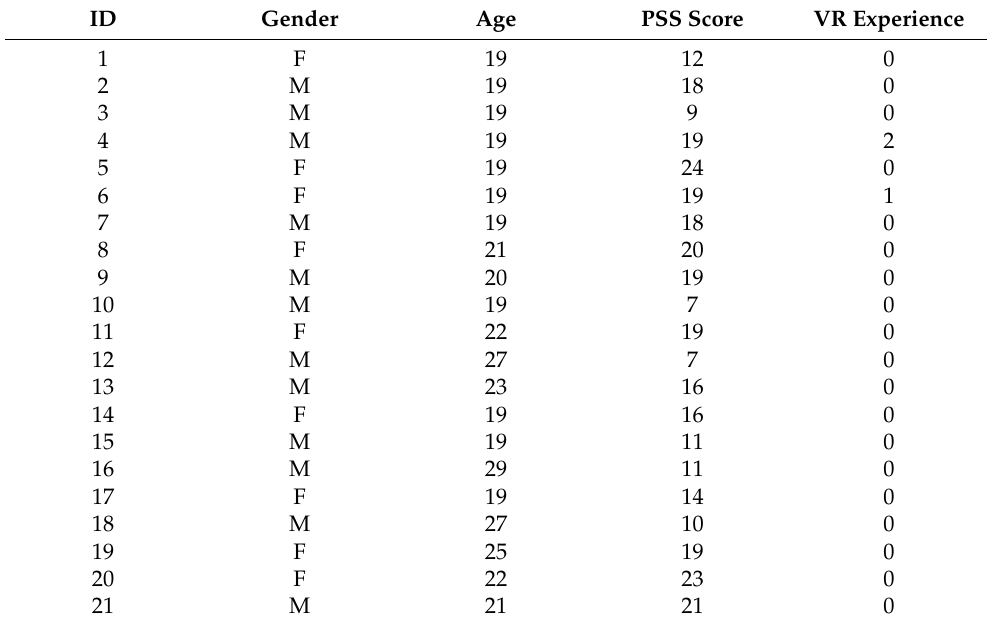
Table A1. Perceived Stress Scales scores for the 21 participants of the experiment. “VR Experience” represents the level of familiarization a participant had with the VR headset. The scale was 0–4, where 0 means no experience and 4 means a lot of experience. No participant had any previous knowledge of the “Richie’s Plank Experience” game.